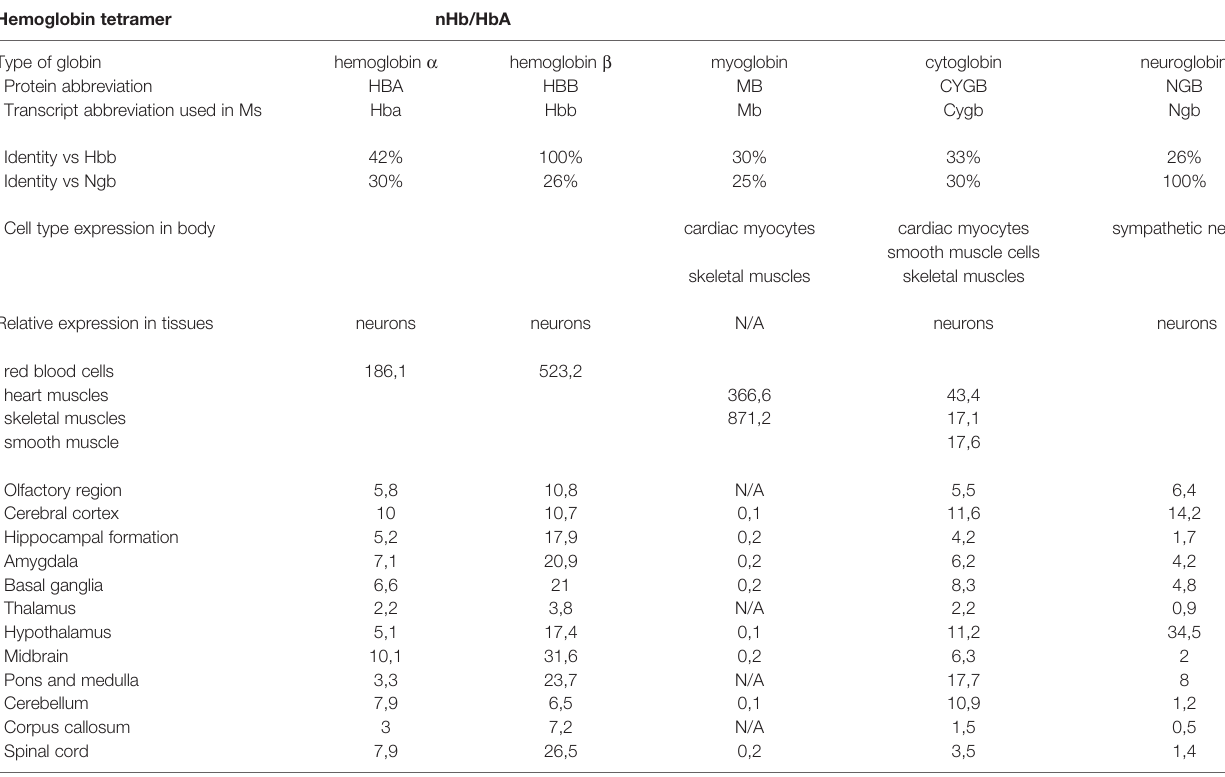
TABLE 1 | Cell type-speci fi c expression of vertebrate globins in the body and in the brain. Hemoglobin tetramer